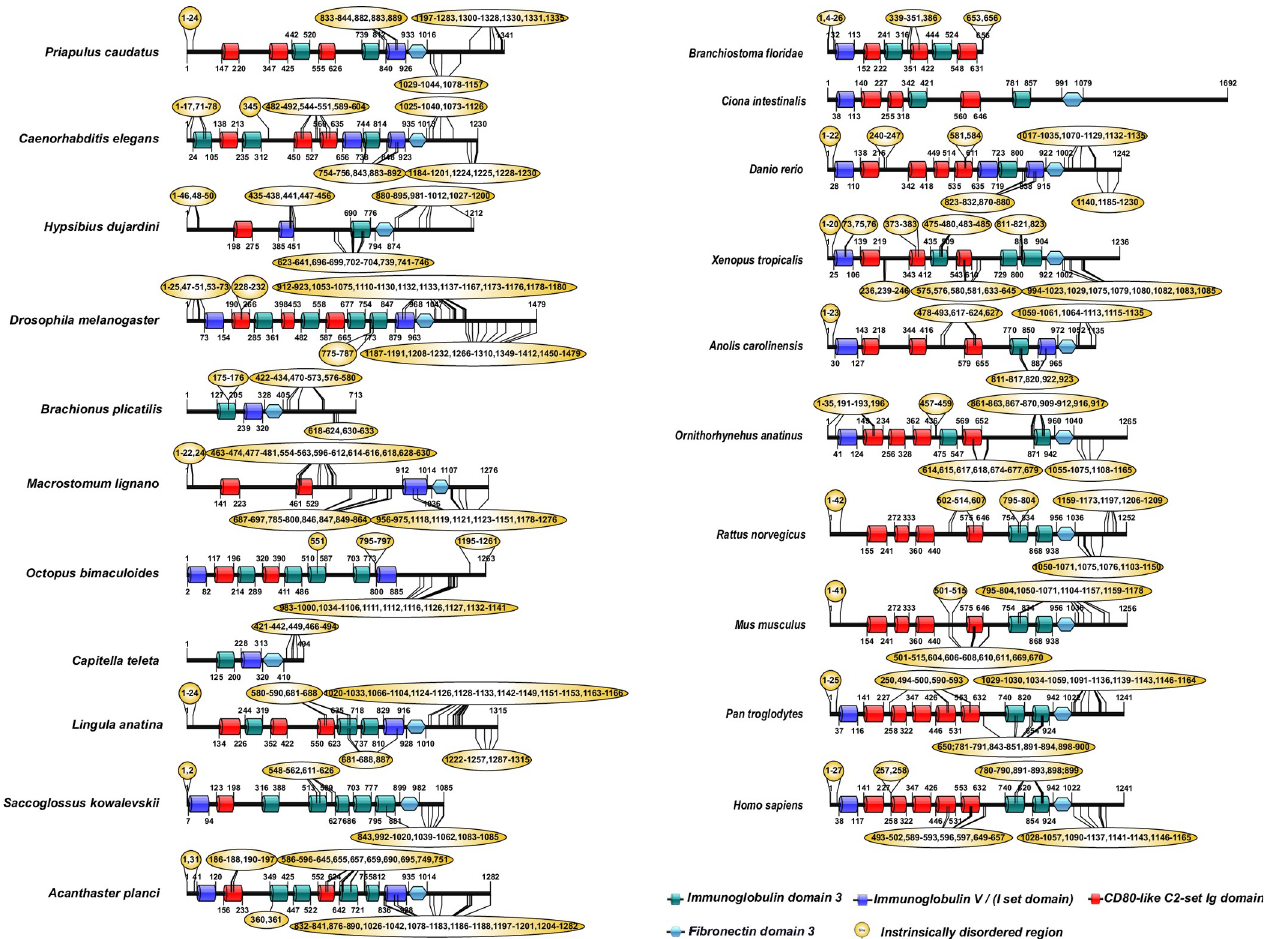
Fig 2. Domain organization in nephrin and its orthologs. Different colors represent Ig domain subsets: Ig3 as green, CD80-like C2-set as red, IgV as blue, FN-3 as light blue, and intrinsically disordered regions as yellow bubbles.